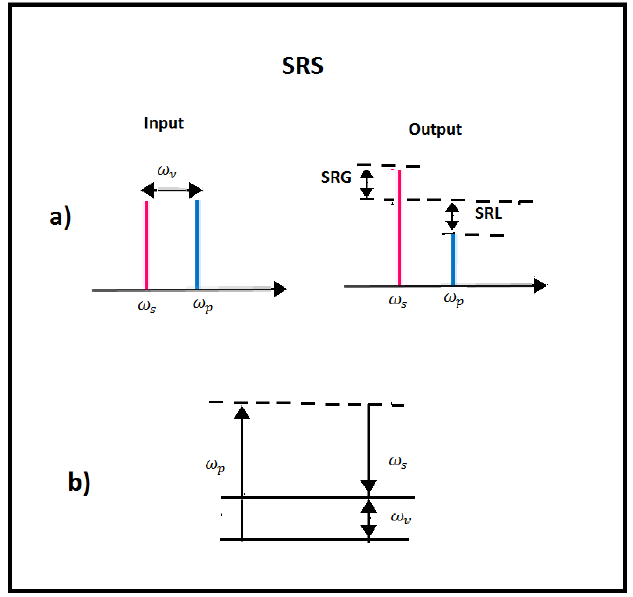
Figure 5. Stimulated Raman scattering. ( a ) SRS modalities: SRG, stimulated Raman gain; SRL, stimulated Raman loss. ( b ) The energy level diagram describing the SRS interaction.